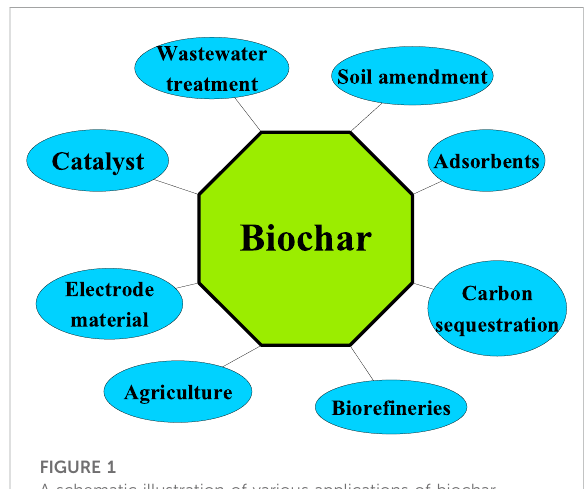
FIGURE 1 A schematic illustration of various applications of